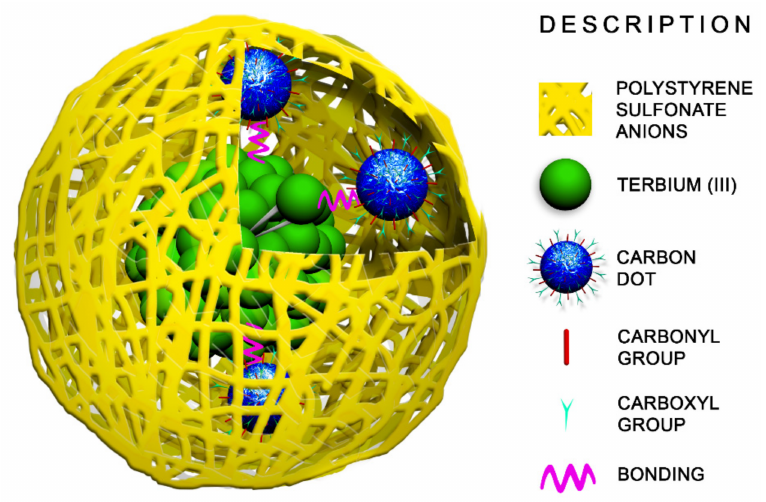
Figure 1. Schematic illustration of PSS-{CDs-[TbL]}